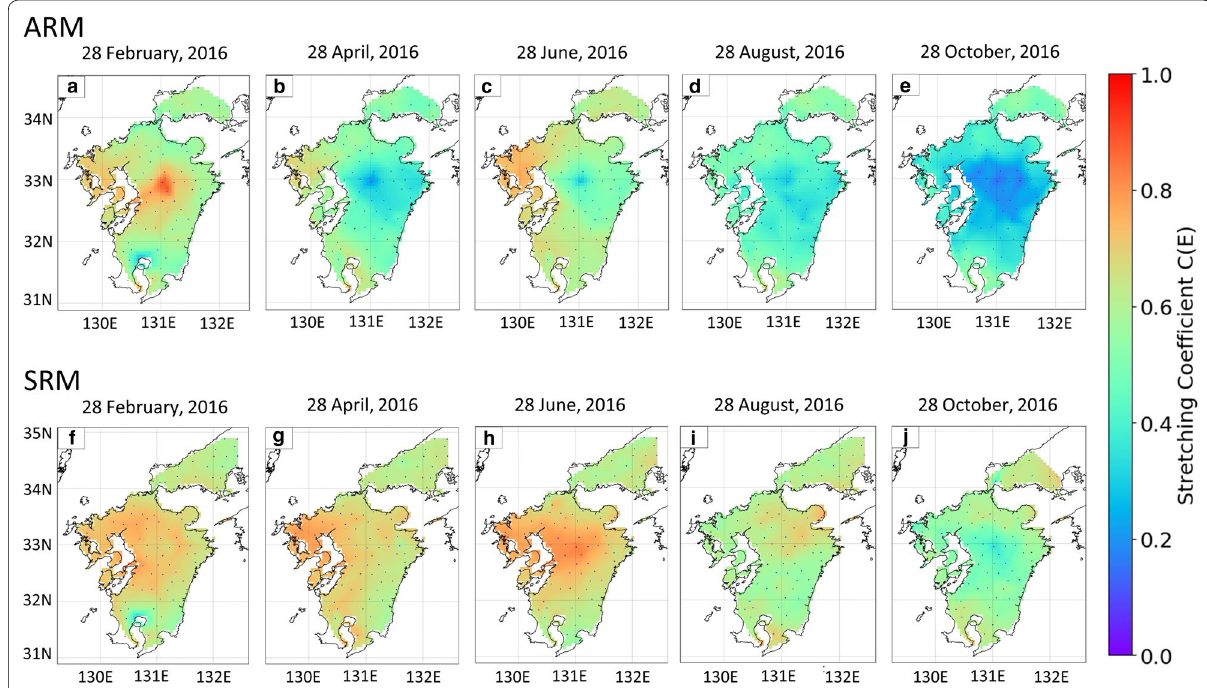
Fig. 8 Stretching coefficient C(E) maps determined by using a – e the ARM and f – j the SRM. The SRM results show higher C(E) values than the ARM results because in the SRM the current trace always overlaps the reference trace. Panels d and e show that C(E) decreased because the current trace has continued to separate in time from the fixed reference trace and also is affected by multiple eruptions, such that the velocity variation could become unstable. The ARM appears to be useful to detect changes in the scatter wave, whereas the SRM determines velocity variations with high stability and high temporal